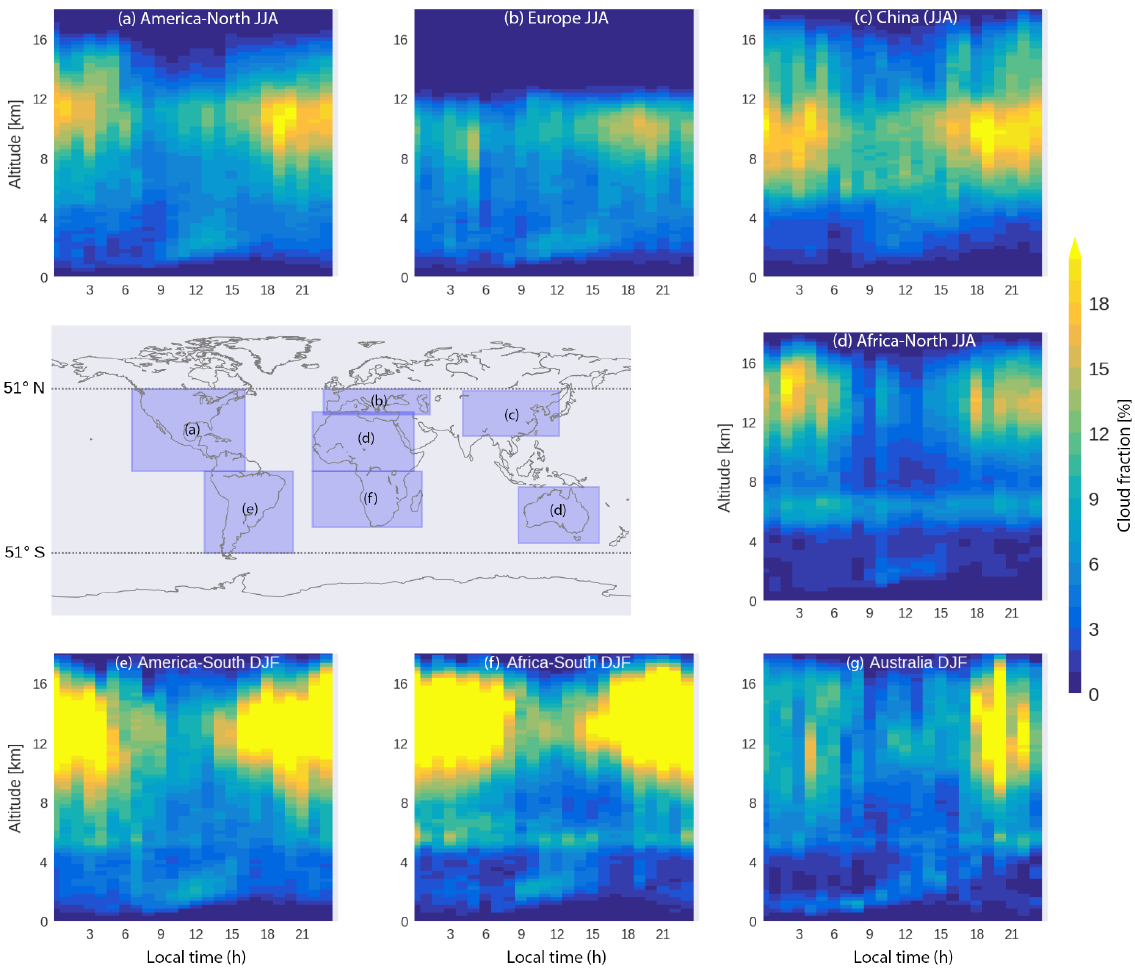
Figure 5. Diurnal cycle of the cloud fraction profiles observed by CATS over different continental regions – (a) NH America, (b) Europe, (c) China, (d) NH Africa, (e) SH America, (f) SH Africa, and (g) Australia – averaged over the summer months (JJA in the Northern Hemisphere and DJF in the Southern Hemisphere) from 2015 to 2017. For each region we considered all profiles sampled over land within the boundaries shown by the inset map. CFs over Europe do not extend to altitudes as high as the rest, as it is the only region that does not include part of the tropical